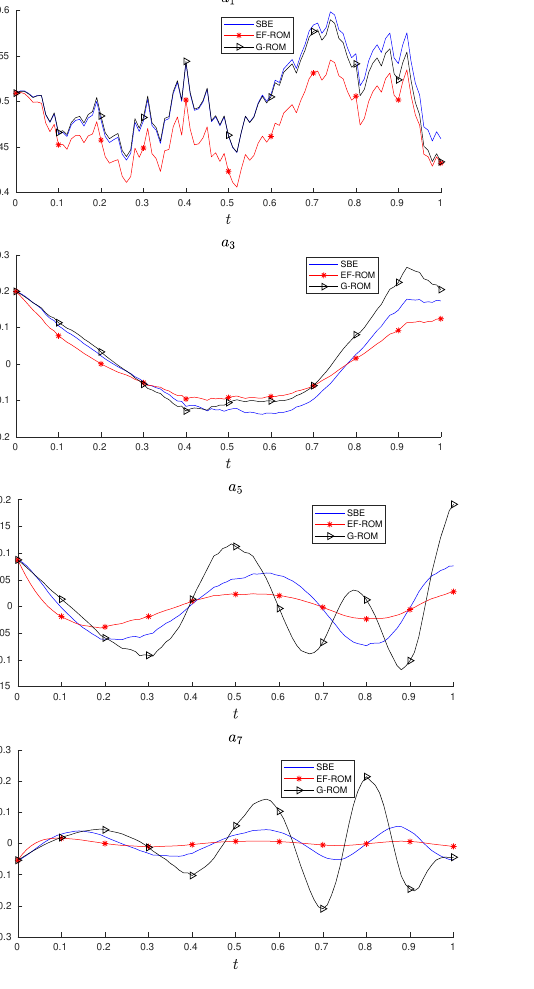
Figure 4. Time evolution of the projected POD coefficients from the solution of G-ROM, EF-ROM and SBE system. The ROM solutions are obtained with σ = 0.3 and r =